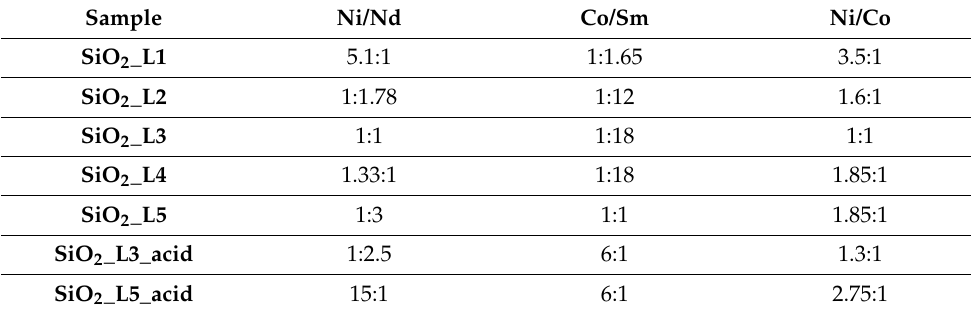
Table 4. Molar ratios of Co and Ni against Sm and Nd by EDS analysis.